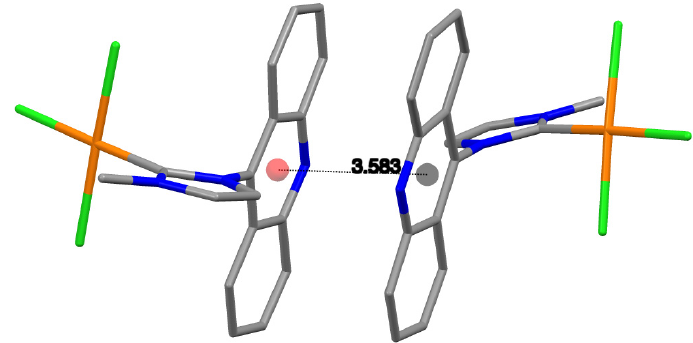
Figure 5. Offset π ··· π stacking interactions of complex 1 .